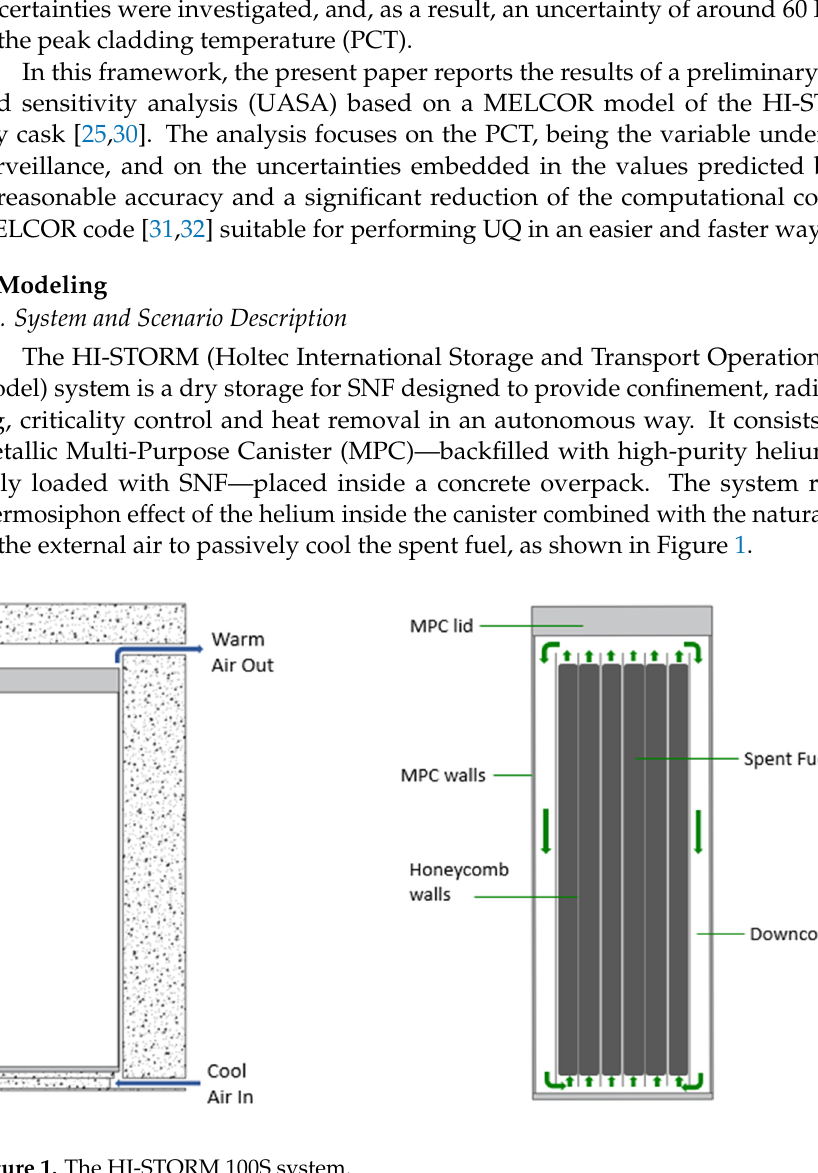
Figure 1. The HI-STORM 100S